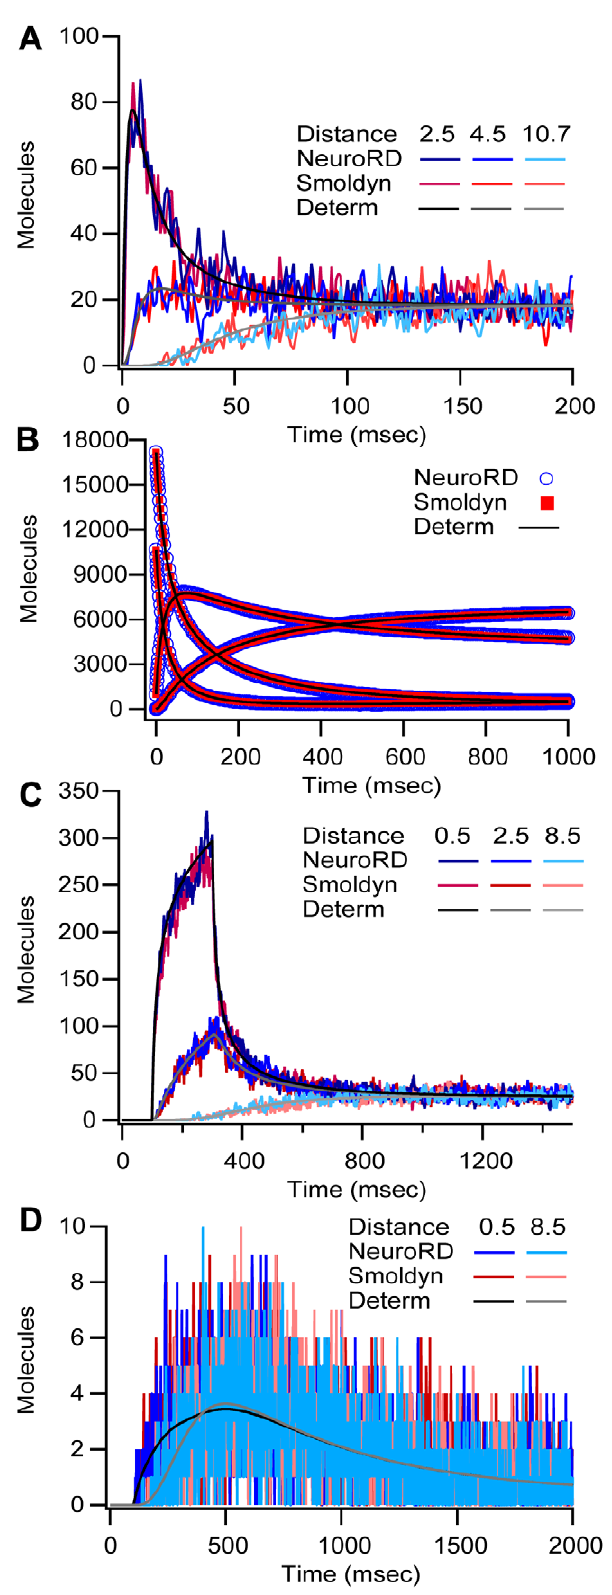
Figure 3. Validation of NeuroRD . Simulations show good agreement between NeuroRD, Smoldyn [25] and deterministic solutions (XPPAUT [38] or Chemesis [39]). (A) Validation of diffusion alone. Deterministic trace generated using Chemesis; (B) Validation of reactions alone.